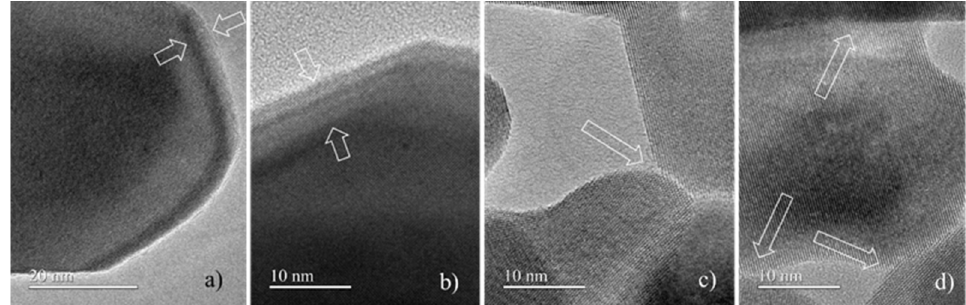
Figure 7. High magnification HRTEM images showing Ce-CMK3 particles in detail: arrows indicate nanoarchitecture regarding surface particle in ( a , b ); and contact between particles in ( c , d ).